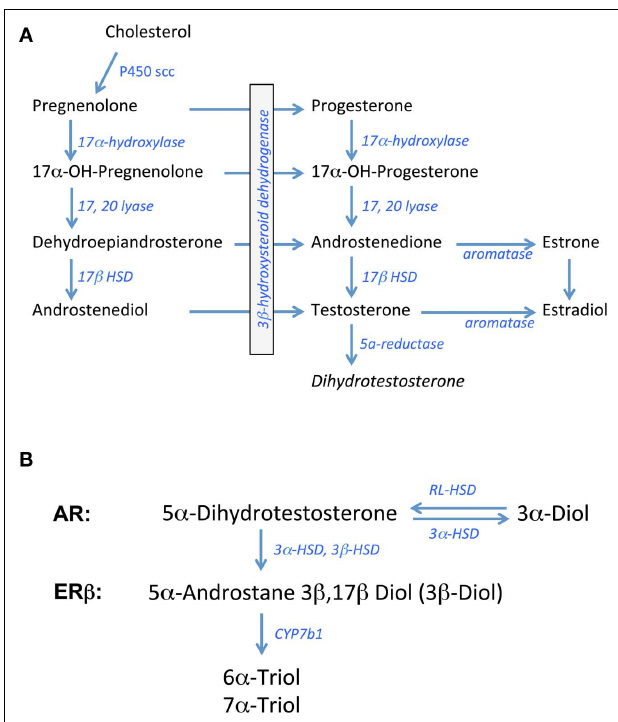
FIGURE 1 | Biosynthetic pathway for gonadal steroid hormones. (A) Shows known enzymes and intermediates leading to the synthesis of estrogens and androgens from cholesterol. (B) Shows the metabolic steps of dihydrotestosterone processing putatively involved in pre-receptor regulation of ERbeta activation. 3 α -Diol = 5 α androstane 3 α , 17 β Diol; 3 β Diol = 5 α androstane 3 β , 17 β Diol, RL-HSD = 11-cis-retinol dehydrogenase like 3 α